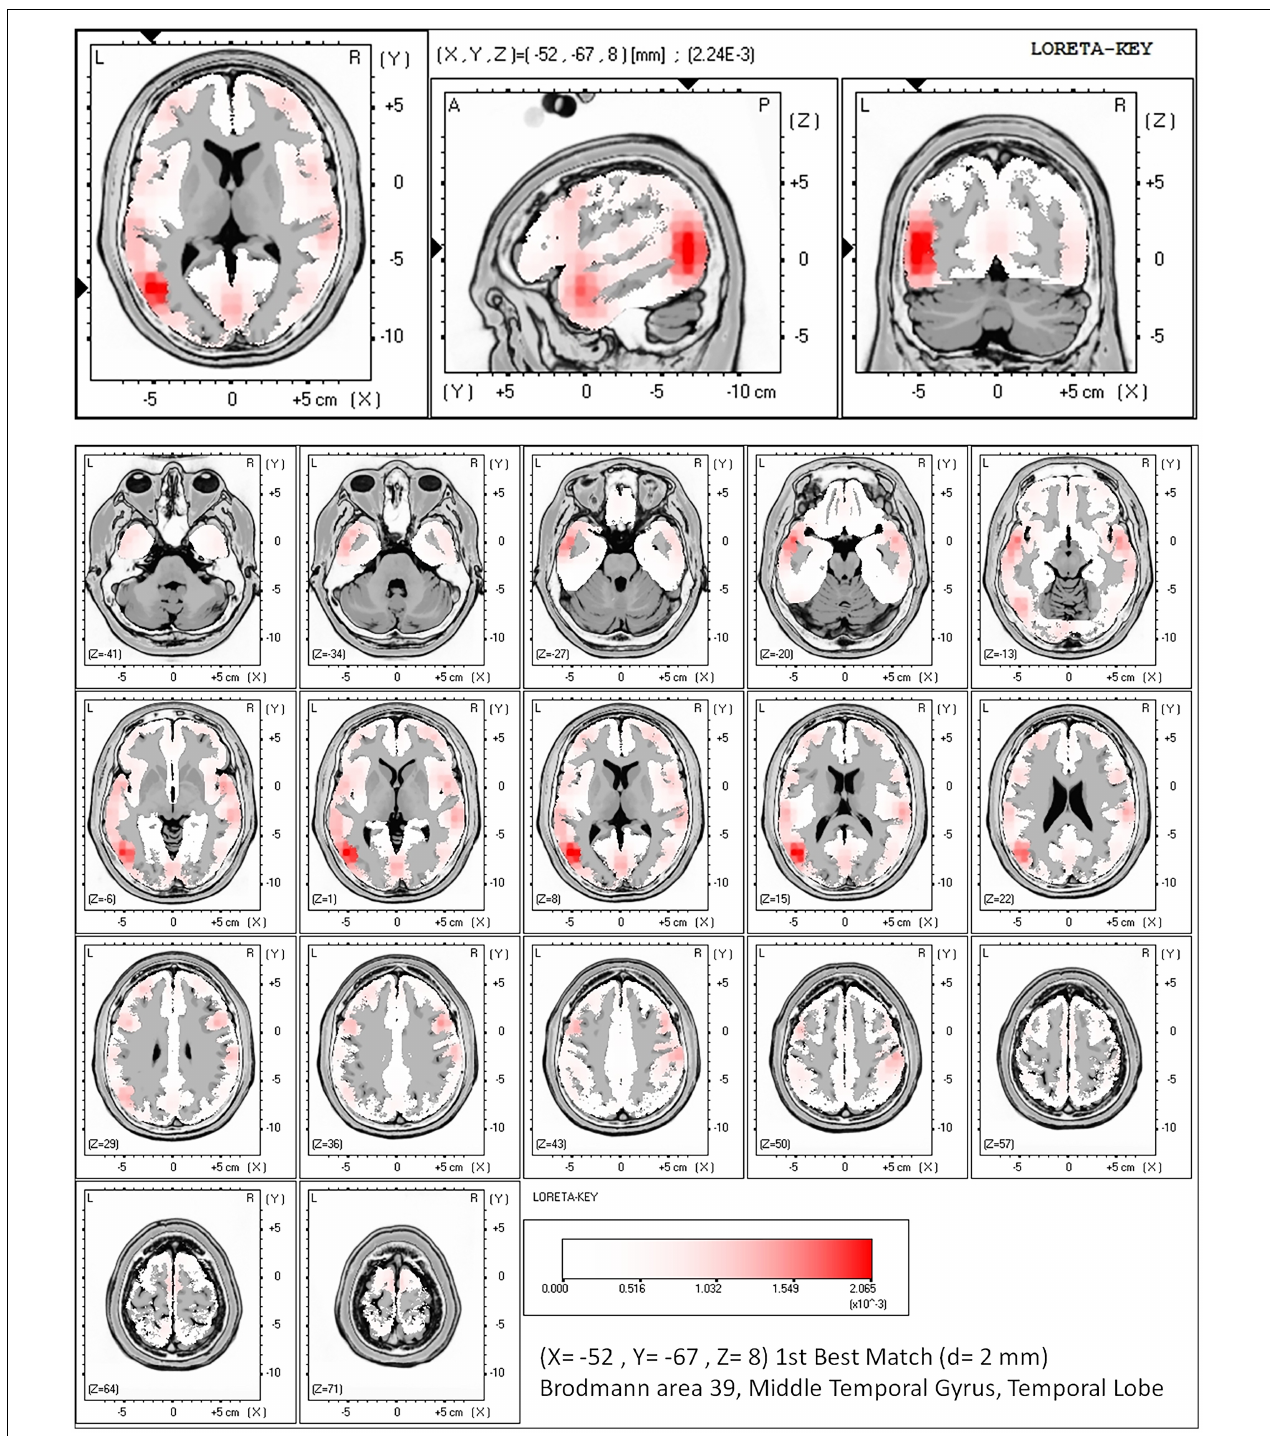
FIGURE 4 | Cortical source analysis of vMMN elicited by high SRI